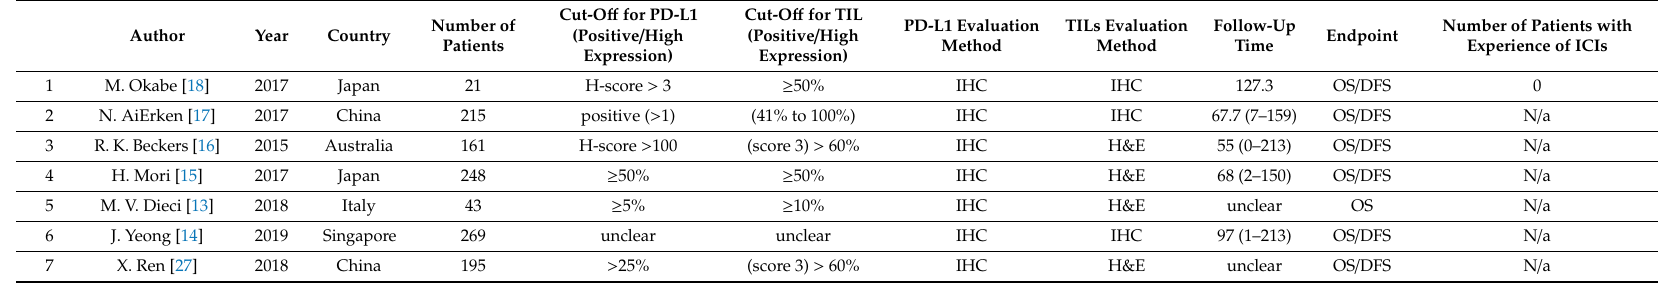
Table 1. Main features of the included studies in the current